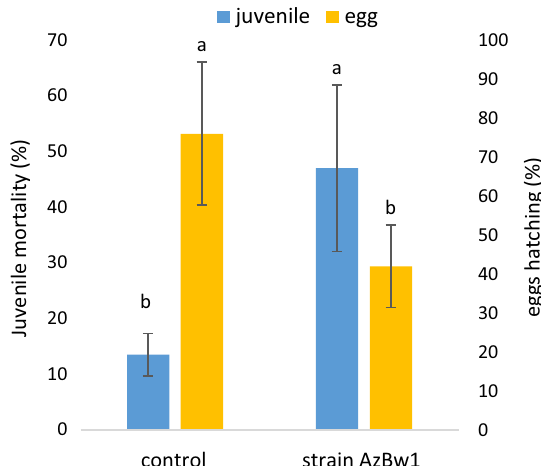
Fig. 1 Nematicidal activity of volatile compounds emitted from strain AzBw1. Strain AzBw1 was streaked on one side of bi‑plate Petri dish and after 5 h, either egg suspension or juveniles were spread on water agar medium in other side of plate. Values followed by the same letter are not significantly different at 1%, as determined by analysis of variance followed by Fisher’s test. Bars indicate standard error. This experiment was conducted twice with the same